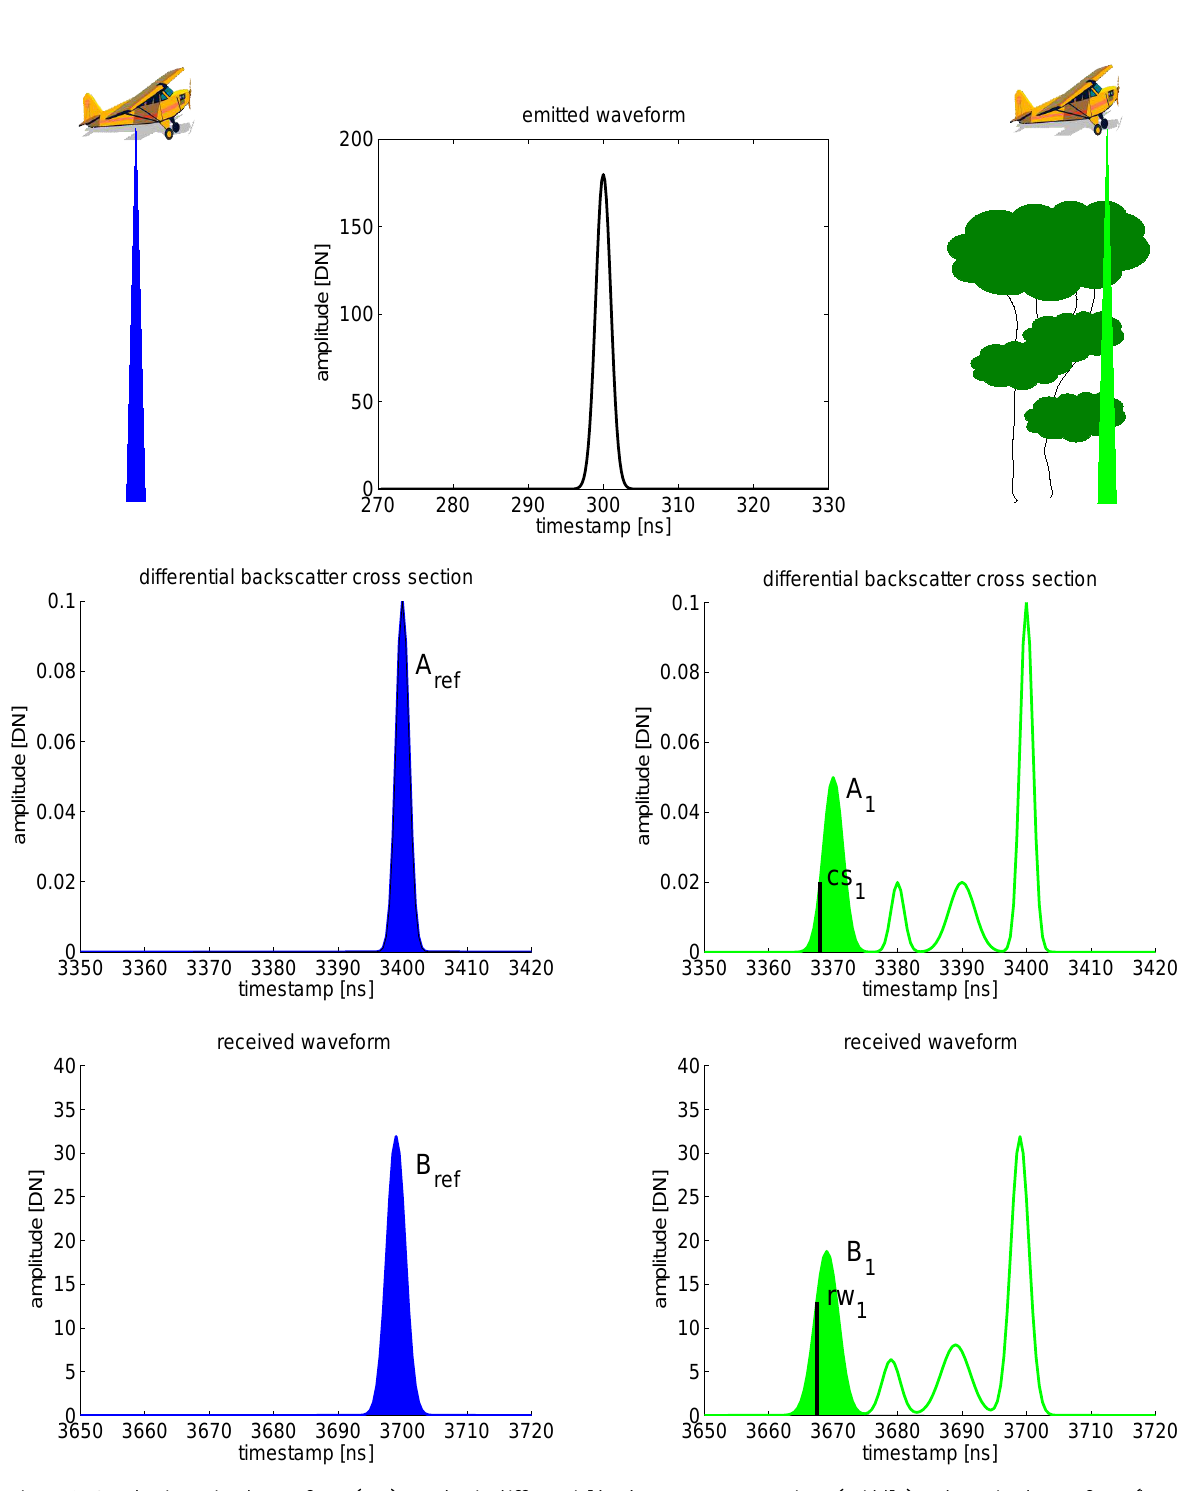
Figure 2: Synthetic emitted waveform (top), synthetic differential backscatter cross sections (middle) and received waveform (bottom) with highlighted areas under the curves ( A ref , B ref , A 1 , B 1